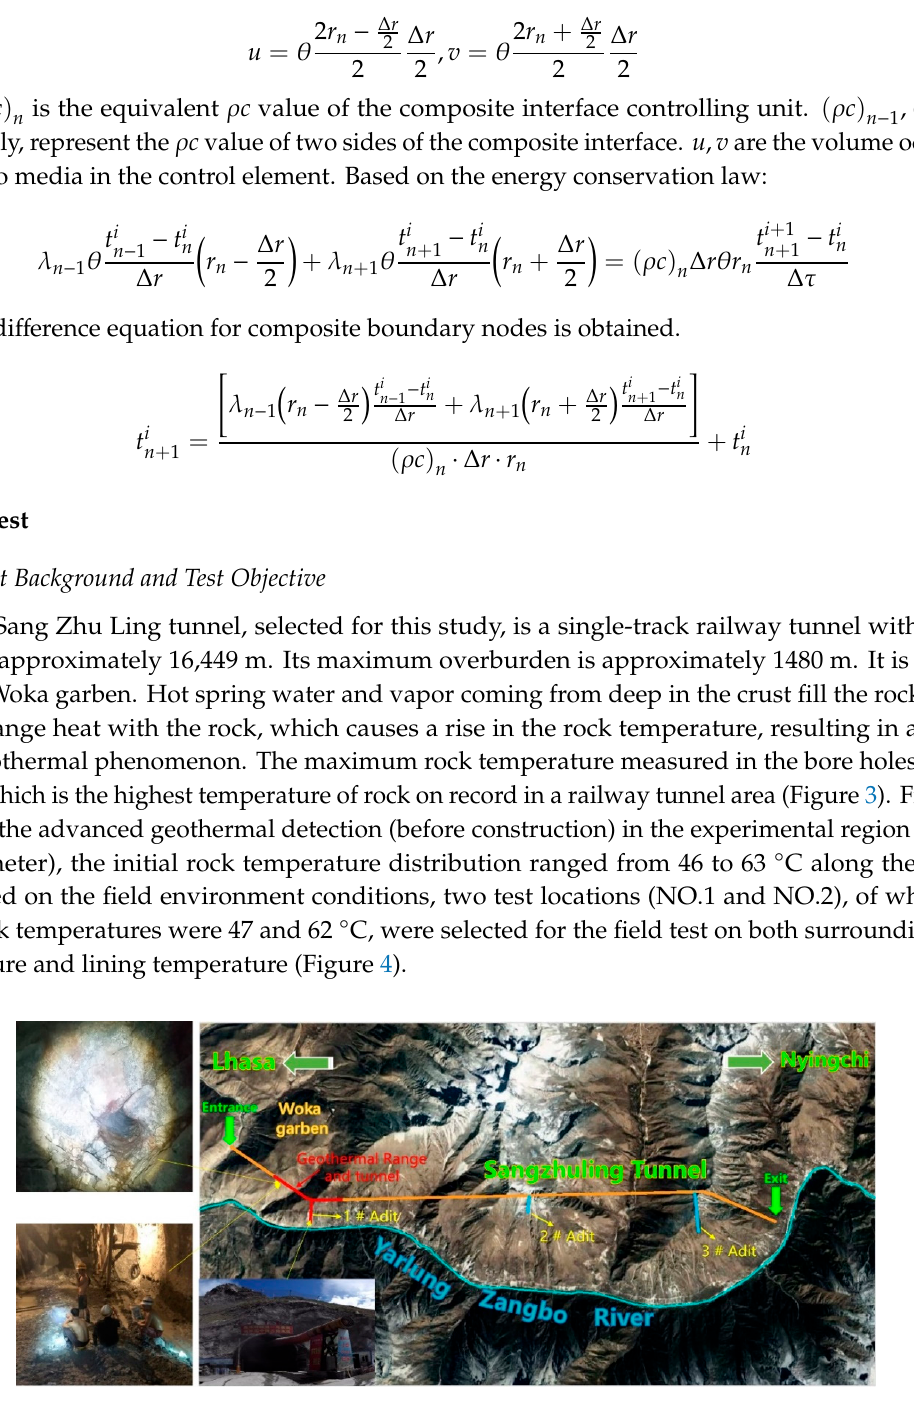
Figure 3. Layout of the Sangzhuling tunnel.